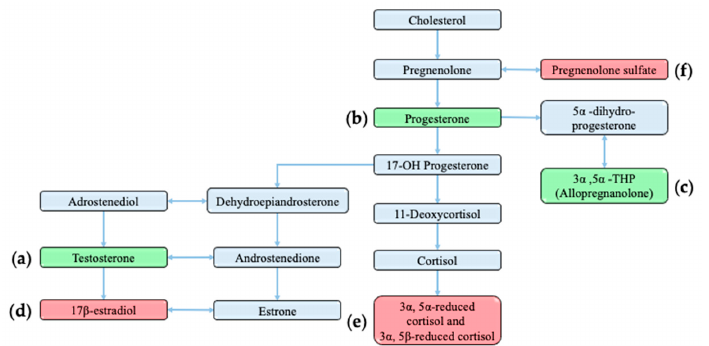
Figure 1. Simplified steroid synthesis pathway. Steroids discussed in this review are highlighted as generally having either excitatory (red) or inhibitory (green) effects on GABA A R. For specific refer- ences to ( a ), ( b ), ( c ), ( d ), ( e ) and ( f ) panels, please see the main text. Figure modified from [28]. Steroid levels fluctuate during specific stages of normal human development, lead- ing to sex-specific differences in a range of traits [29]. In epilepsy patients, these fluctua- tions in steroid levels during puberty and menopause are linked to changes in seizure frequency [30,31]. CE seizure onset and offset generally correlate with changes in sex ster- oid levels during minipuberty and puberty (Figure 2a) [25]. Sex steroid levels and their neuroprotective effects falling below a threshold after minipuberty may, therefore, open an opportunity for various stressors, such as infection and associated fever, to facilitate the onset of CE. The onset of seizures with low hormonal levels during this developmental period might also be simply coincidental, which is yet to be determined. Seizures often offset when sex steroid levels rise above a threshold during puberty, and thus may pro- vide an anticonvulsant protective effect [25]. To determine if CE girls are deficient in other steroids during development, Trivisano et al. (2017) [26] investigated the steroid levels of pre- and postpubertal CE girls. Although they observed a significant reduction in cortisol and pregnenolone sulfate (PS) levels in postpubertal CE girls (Figure 1e,f), prepubertal CE girls showed no difference in hormonal levels when compared to those of controls. The stimulation of adrenal steroidogenesis through adrenocorticotropic hormone (ACTH) ad- ministration to pre- or postpubertal CE girls did not increase PS levels to that of controls. Furthermore, an increase in cortisol levels due to ACTH stimulation was less sustained in prepubertal CE girls than that in the controls [26]. This study shows that there is an ab- normal adrenal response in CE individuals throughout development and changes in ster- oid levels postpuberty. Taken together, these investigations strongly suggest alerted steroidogenesis in seizure-active CE girls. However, steroid-level variations during CE seizure onset and offset have not yet been investigated.